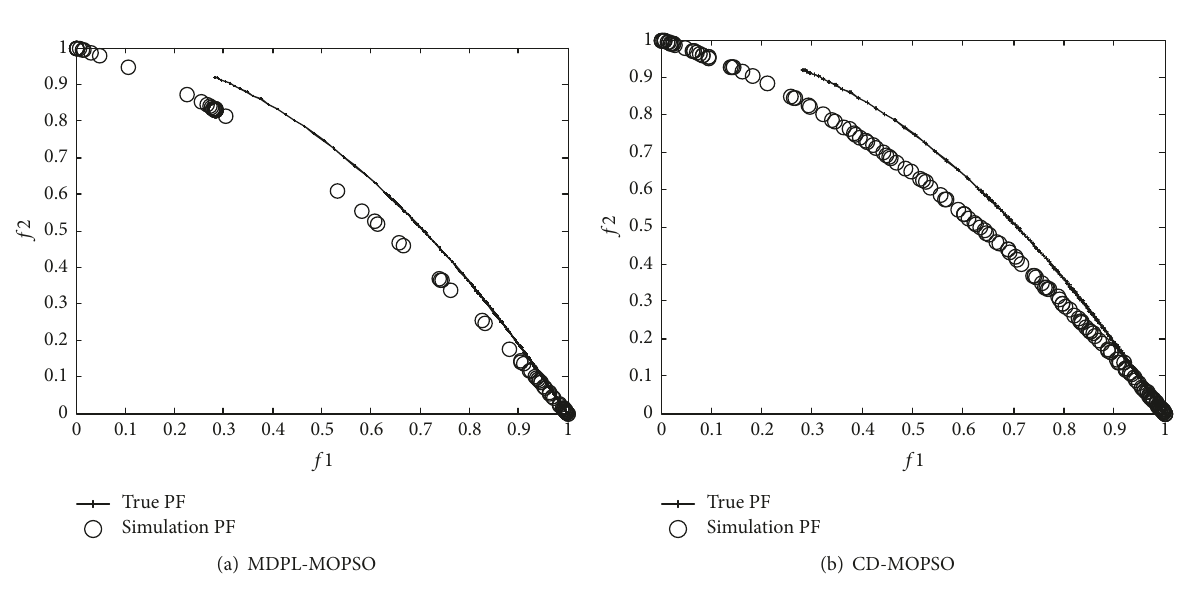
Figure 11: Nondominated solutions with MDPL-MOPSO and CD-MOPSO on ZDT4.